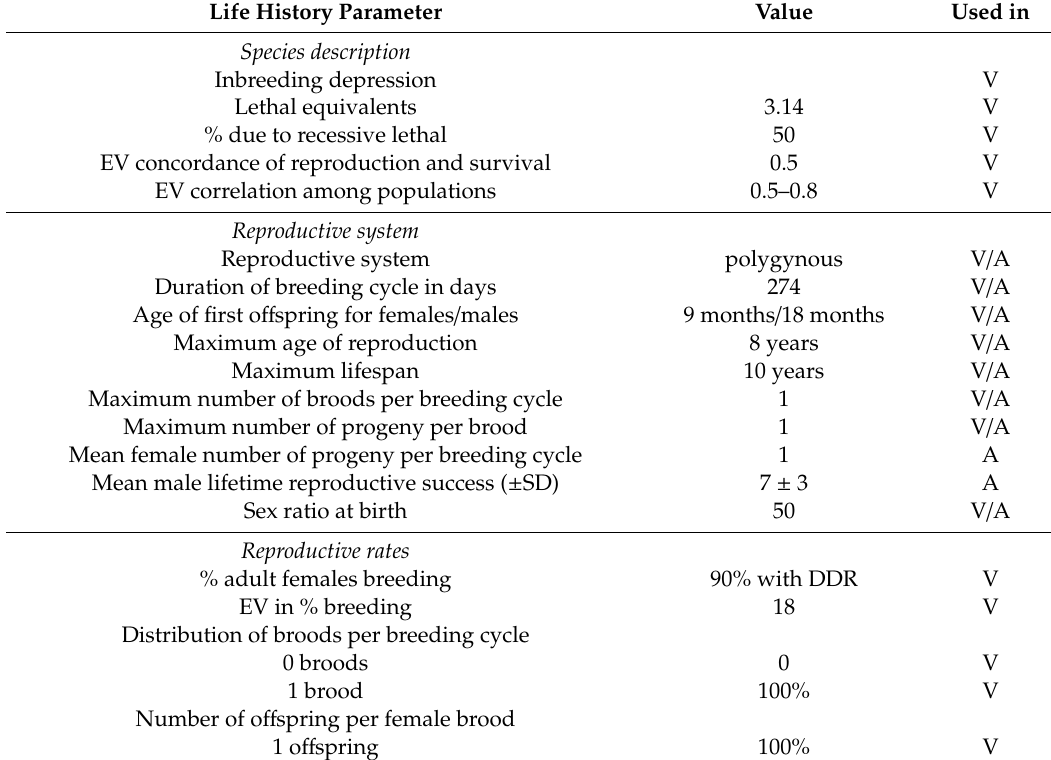
Table 1. Life history parameters used for L. fasciatus population modelling in VORTEX and ALLELERETAIN. Parameter values were obtained from data in [33,34,41,70] and refined by C.S. and J.S. Where a parameter is not listed, defaults are used. V: VORTEX; A: ALLELERETAIN; EV: environmental variation; BHW: banded hare wallaby; DDR: density-dependent reproduction